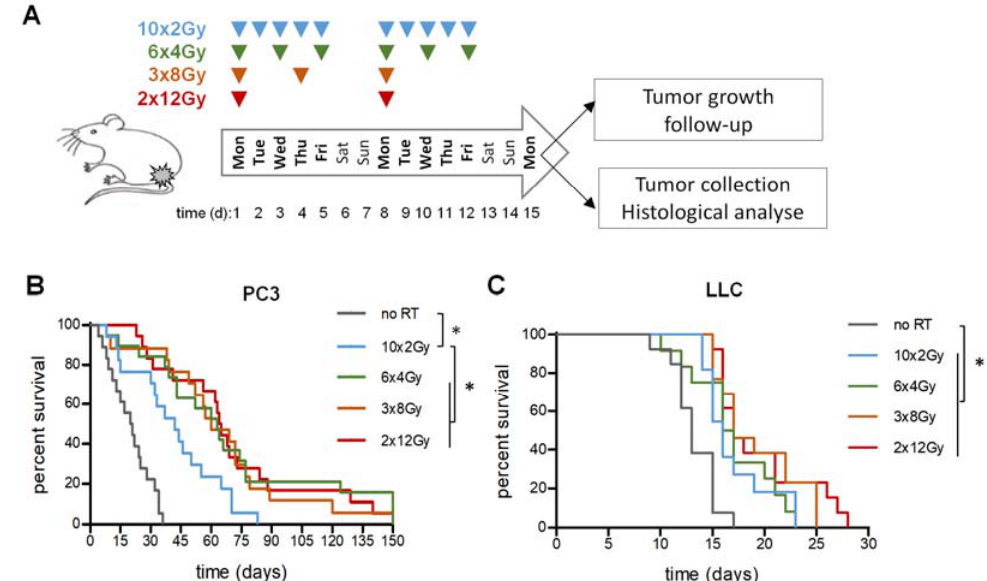
Figure 1. Tumor control in response to radiotherapy (RT) fractionation schedule. ( A ) Experimental calendar of fractionation. ( B , C ) Kaplan–Meier survival estimates of PC3 ( B ) and LLC ( C ) tumor-bearing animals. Established tumors were irradiated as indicated and animals were counted dead when the tumor volume reached 2000 mm 3 . Experiments were done twice with a total of n ≥ 15 per group. * indicates p < 0.05.